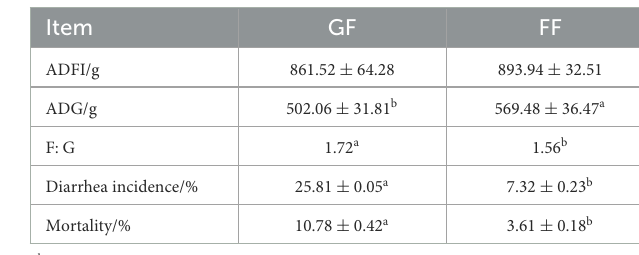
TABLE 4 Effects of dietary FF on growth performance in weaned piglets ( n =